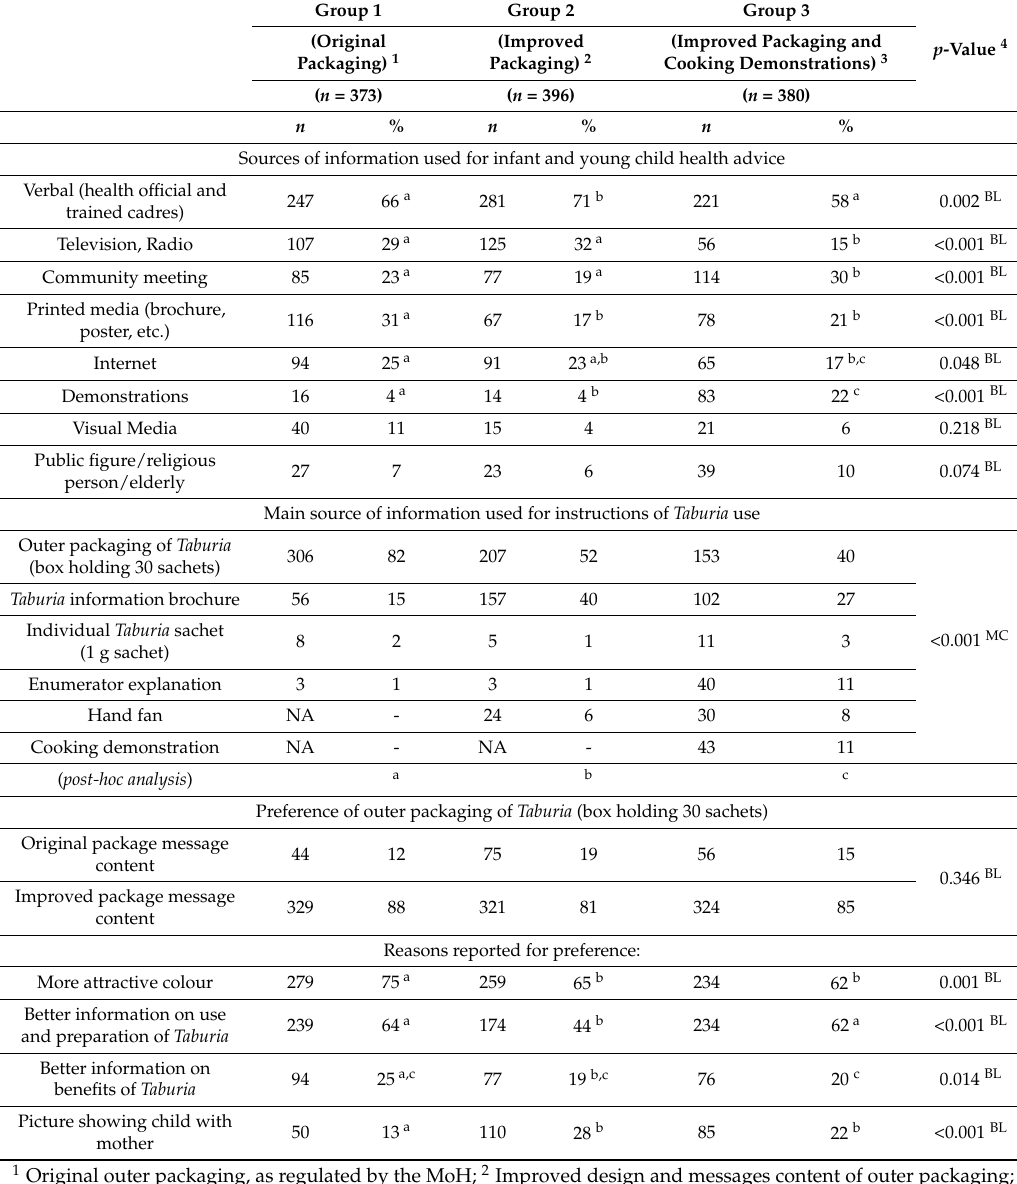
Table 4. Main source of information on use and preparation of Taburia used by caregivers and preference of packaging 30 days after